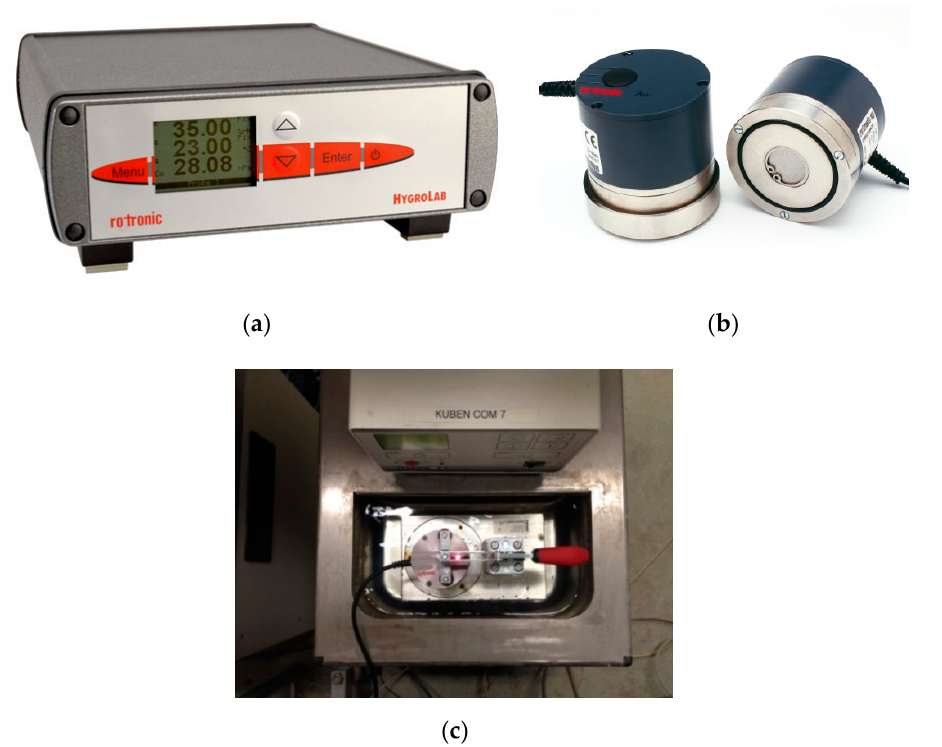
Figure 4. Apparatus for internal relative humidity measurement; ( a ) Rotronic HygroLab C1; ( b ) HC2- Figure4. Apparatusforinternalrelativehumiditymeasurement; ( a )RotronicHygroLabC1; ( b )HC2-AW AW RH station probes; ( c ) Top view of temperature-controlled water bath. RH station probes; ( c ) Top view of temperature-controlled water